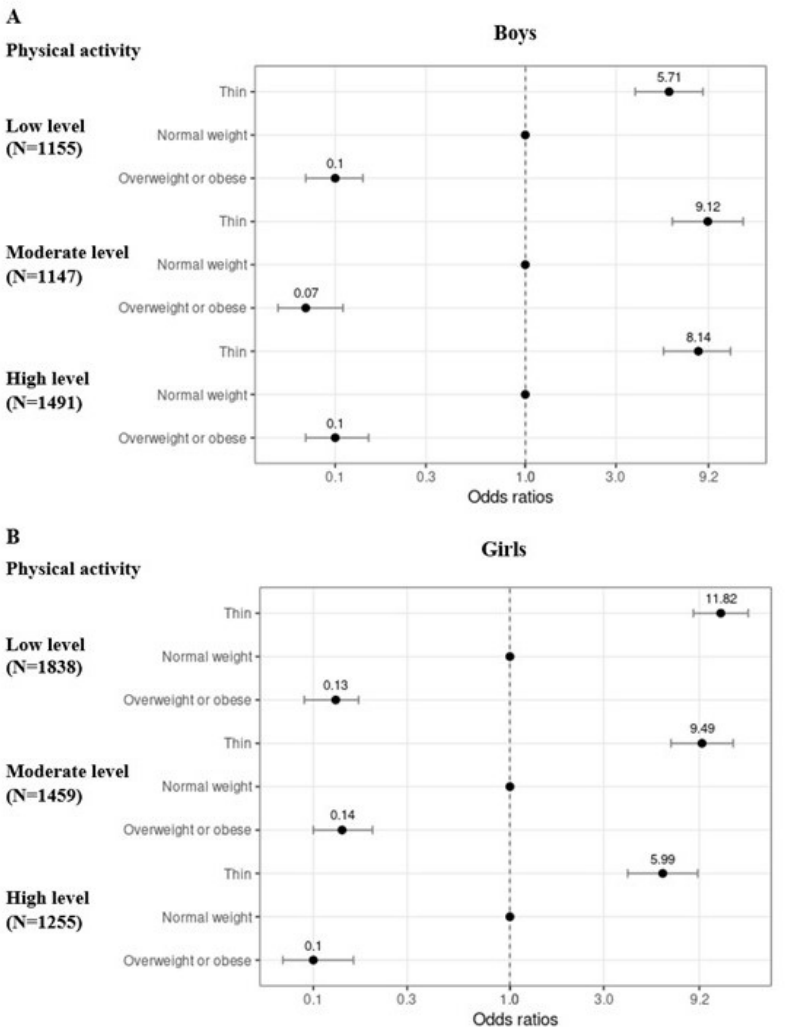
Figure 2. Odds ratios with their 95% confidence intervals from ordinal regression analyses showing the risk for wishing for a bigger body compared to being satisfied or wishing for a smaller body in different body mass index stratified by physical activity level separately for boys ( A ) and girls (B ). Normal weight is a reference group. Low PA level indicates PA around 5 h a week or less, moderate PA level indicates PA around 6–8 h per week, and high PA level indicates PA around 9 h per week or